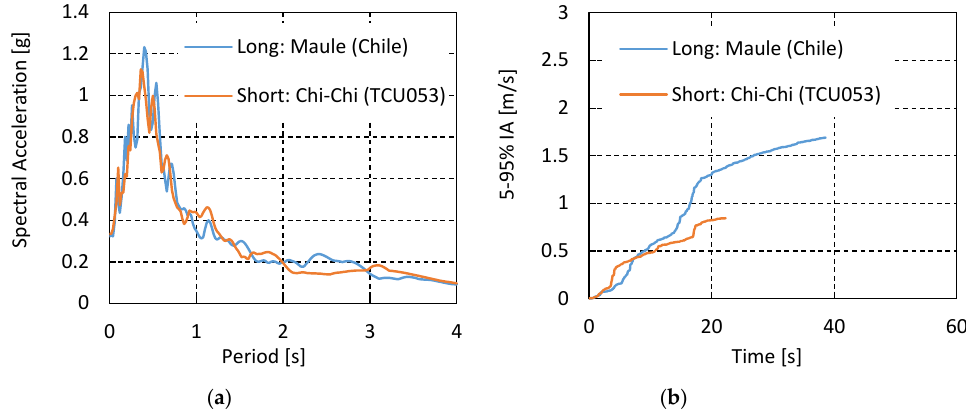
Figure 5. ( a ) Response spectra; ( b ) Husid plots of the SD and LD record pair.